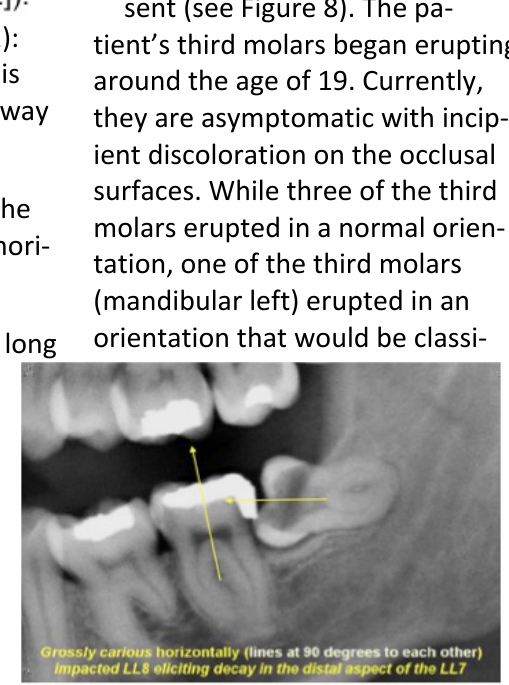
tongue) impacted. 6. Transverse (Figure